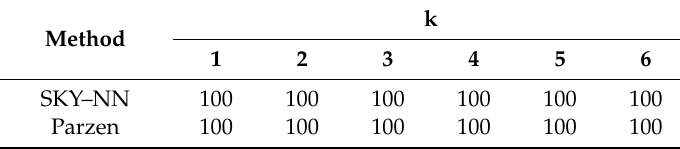
Table 21. Smart skyline on the synthetic Dataset III.